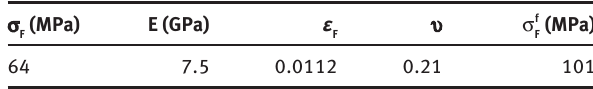
Table 3: Mechanical characteristics of face sheet.